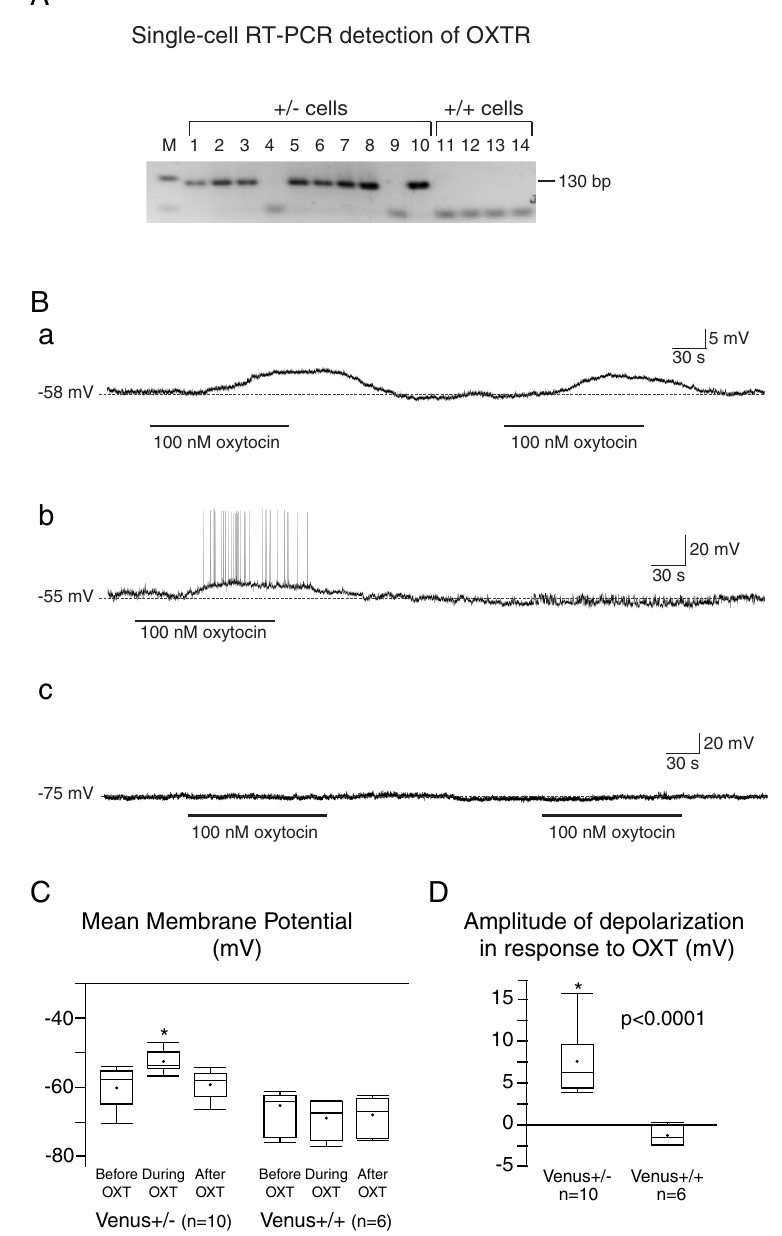
Fig 4. OXTR-Venus cells in the AVPV express functional OXTR. A . Single-cell RT-PCR analysis of OXTR expression in OXTR-Venus cells. Expression of OXTR mRNA was detected in 8 of 10 Venus cells harvested from OXTR-Venus heterozygous (+/-) females, but not detected from any of 4 OXTR-Venus cells obtained from homozygous (+/+) females. B. Examples of the effect of oxytocin on membrane potential and the firing pattern of OXTR-Venus (+/-) cells. a . Bath applications of oxytocin (100 nM) repeatedly caused membrane depolarization. b . The oxytocin-mediated depolarization caused repetitive firing. c . Application of oxytocin had no effect on OXTR-Venus (+/+) cells. C. In OXTR-Venus (+/-) cells, the mean membrane potentials before, during, and after the application of oxytocin (100 nM) were -60.36 ± 5.97 mV, -52.76 ± 3.47 mV, and -60 ± 3.74 mV, respectively. The application of oxytocin resulted in significant depolarization in OXTR-Venus (+/-) cells. In OXTR-Venus (+/+) cells, the mean membrane potentials before, during, and after the application of oxytocin (100 nM) were -67.57 ± 2.39 mV, -68.73 ± 2.35 mV, and -68.02 ± 2.24 mV, respectively. The application of oxytocin did not cause significant change in membrane potentials of OXTR-Venus (+/+) cells (F (2,4) = 1.33, p = 0.19). D. The mean amplitude of depolarization in response to application of oxytocin was significantly (t (14) = -5.35; p < 0.0001) greater among OXTR-Venus (+/-) cells (7.6 ± 1.004 mV) than in OXTR-Venus (+/+) cells (-1.17 ± 1.3 mV).